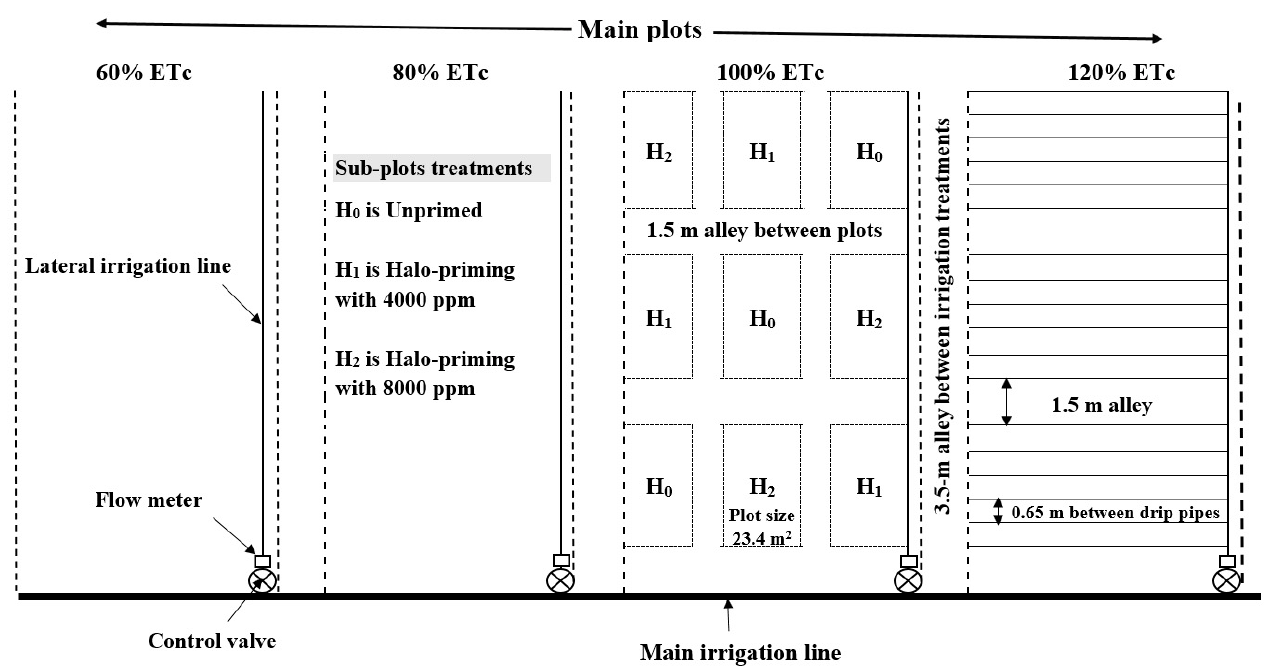
Figure 1. The experiment layout displaying four irrigation regimes in main plots and seed halo-priming treatments in subplots.